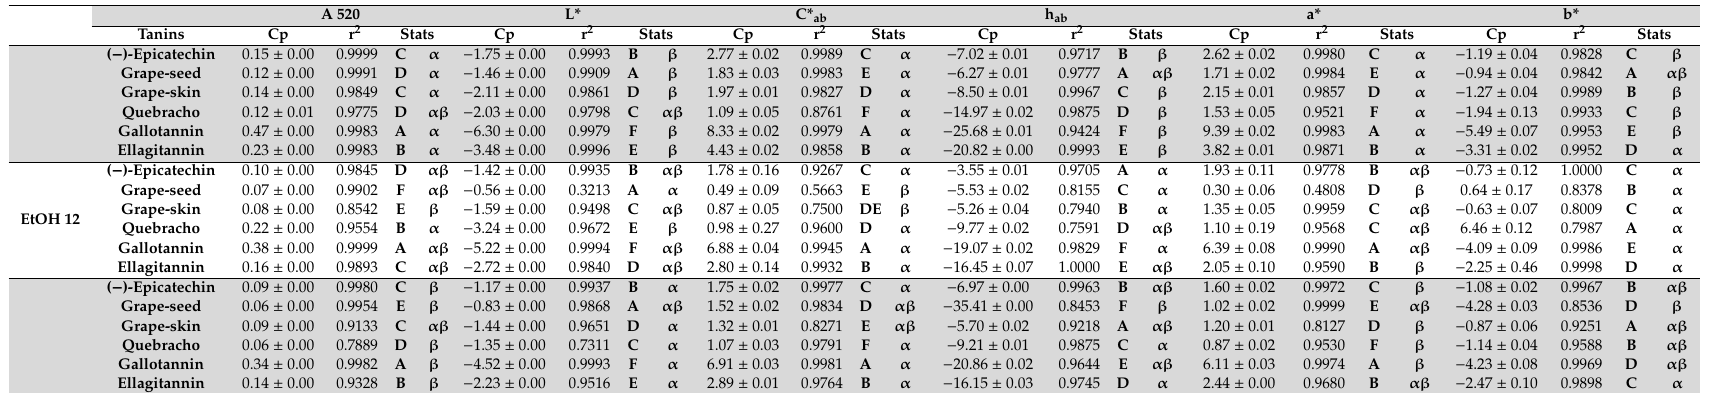
Table 3. Copigmentation e ff ectiveness (Cp) of model wine solutions of malvidin-3- O -glucoside (50 mg / L) at di ff erent ethanol (EtOH) contents, supplemented with increasing concentrations of ( − )-epicatechin and oenological tannins after one week of